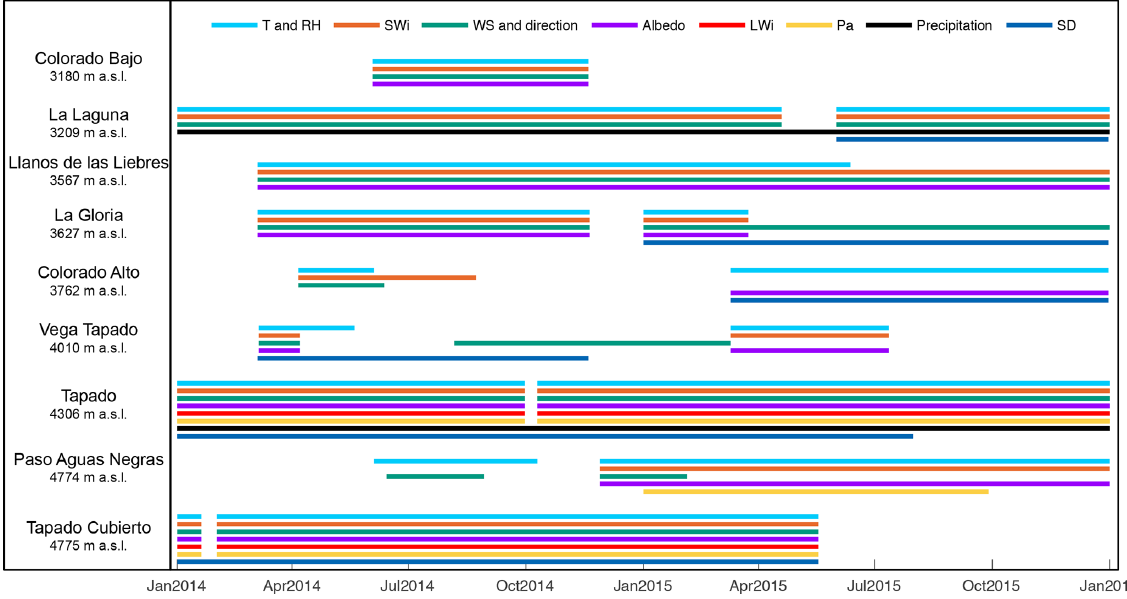
Figure 2. Date of available measurements from the nine AWSs used to calibrate and validate the model. T is the air temperature, RH the relative humidity, SWi and LWi the incoming shortwave and longwave radiation, respectively, WS the wind speed, Pa the atmospheric pressure, and SD the snow